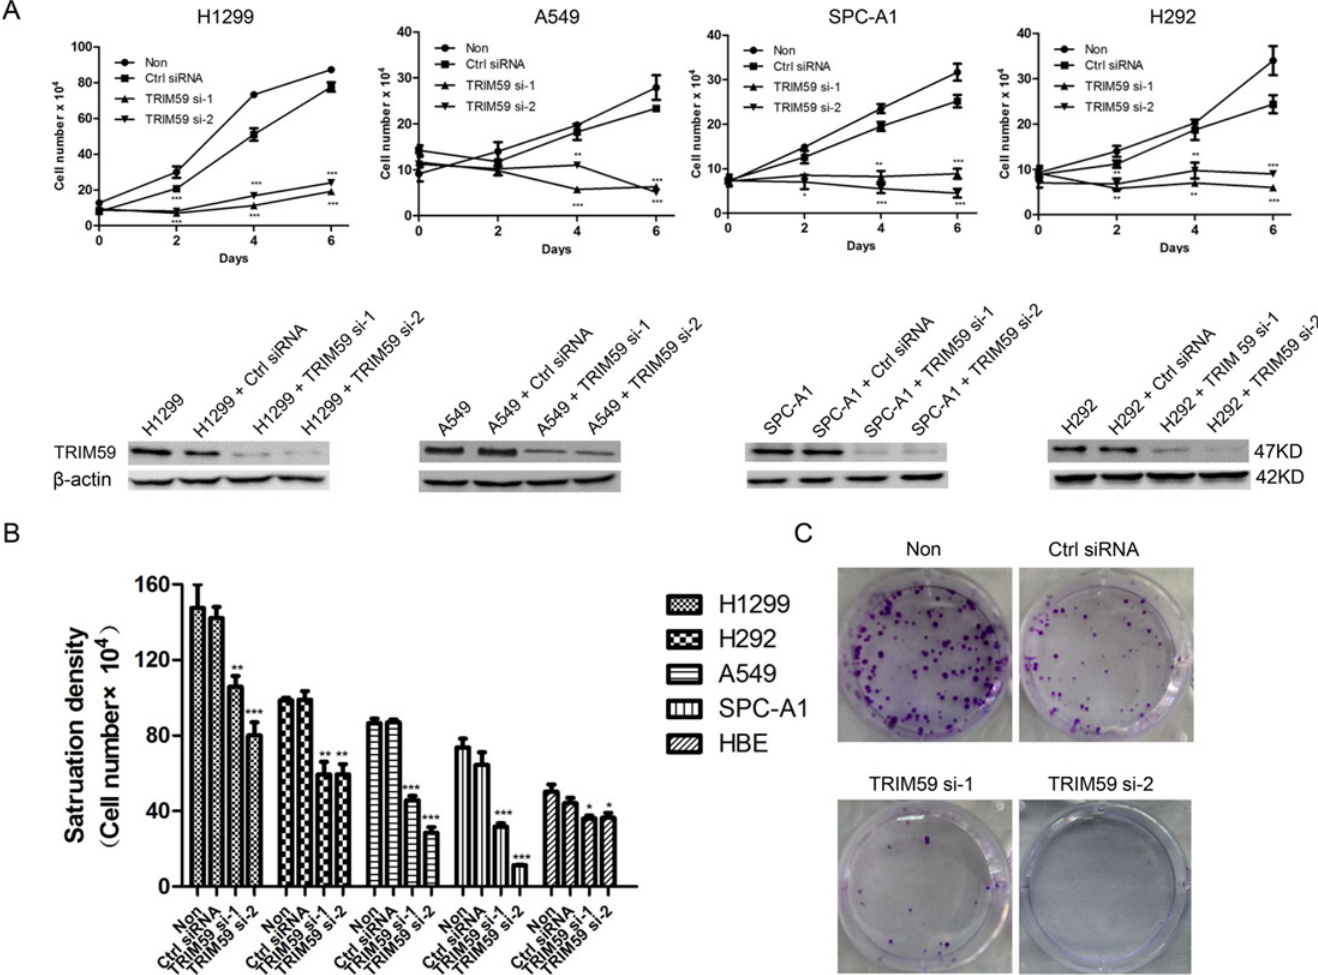
Fig 2. TRIM59 promotes the proliferation of NSCLC cells. (A) Low serum assay. The indicated NSCLC cell lines transiently transfected with TRIM59 siRNA-1, TRIM59 siRNA-2, control siRNA or untransfected were cultured in RPMI 1640 medium supplemented with 1% FBS. At the indicated times, cells were trypsinized and counted. The data represent the average of three independent experiments (mean ± SD) (Top figures). Immunoblot of TRIM59 to check the knockdown efficiency of TRIM59 siRNAs in the indicated cell lines (Bottom figures). (B) Saturation density assay. The indicated NSCLC cells transiently transfected with TRIM59 siRNA-1, TRIM59 siRNA-2, control siRNA or untransfected were cultured in RPMI 1640 supplemented with 10% FBS for 6 days, trypsinized and counted. The data represent the average of three independent experiments (mean ± SD). (C) Colony formation assay. Five hundred H1299 cells transiently transfected with TRIM59 siRNA-1, TRIM59 siRNA-2, control siRNA or untransfected were seeded in 6-well plates in RPMI 1640 with 5% FBS. After two weeks, cells were fixed and stained with crystal violet. Representative wells were photographed and shown.